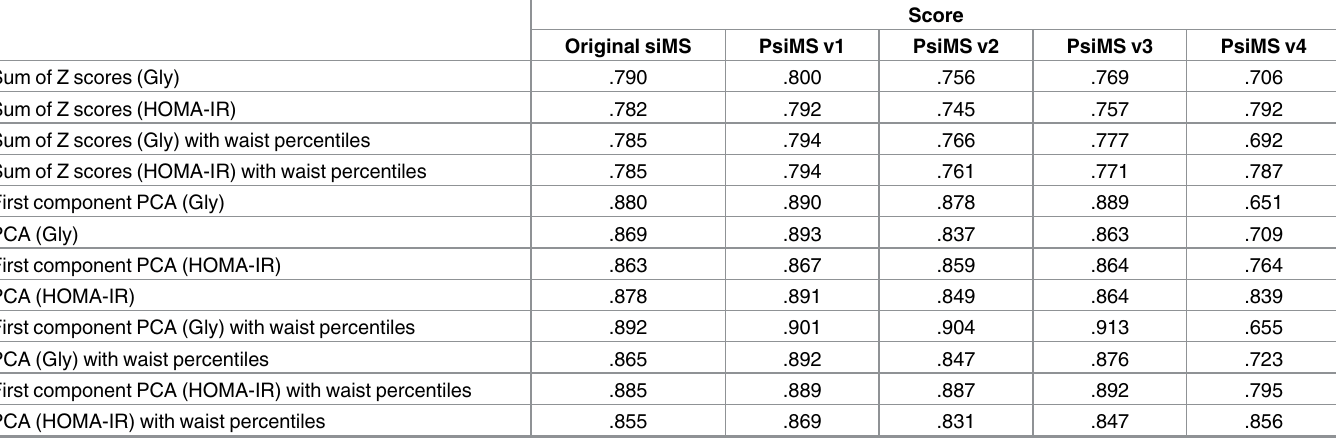
Table 1. Correlation analysis of PsiMS score variants with sums of Z scores of factors and weighted sum of factors derived from principal compo- nent analysis *